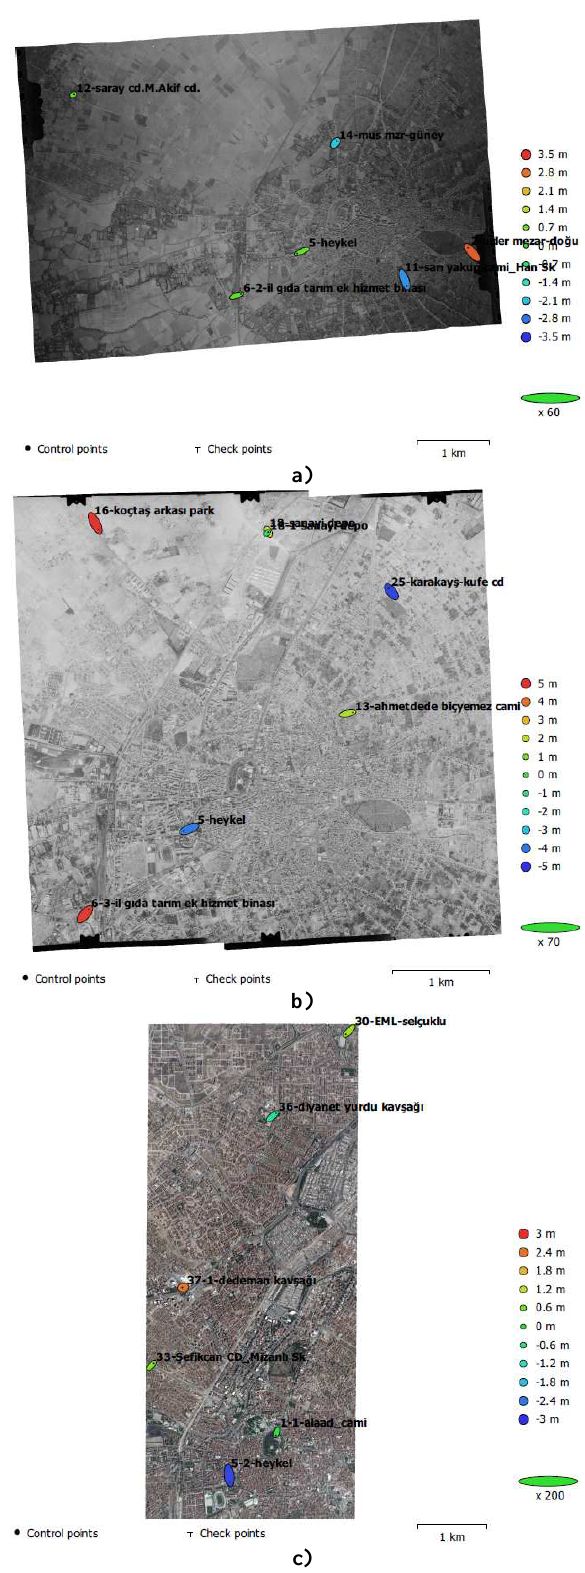
Figure 3. GCP locations and estimated errors on orthophoto images. a) The year of 1951, b) 1975 and c)